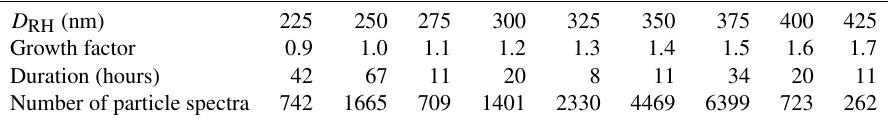
Table 1. Statistics of the D RH , GF, sampling duration and the number of chemically analyzed particles from the ATOFMS ( D dry = 250nm, RH =